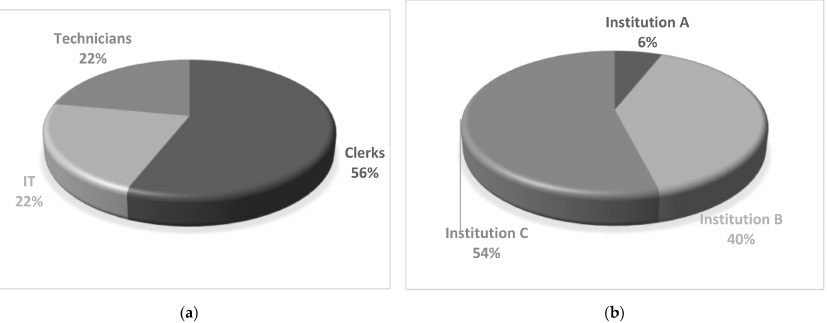
Figure 2. Campaign General Participation Information: ( a ) Expertise, ( b ) Healthcare